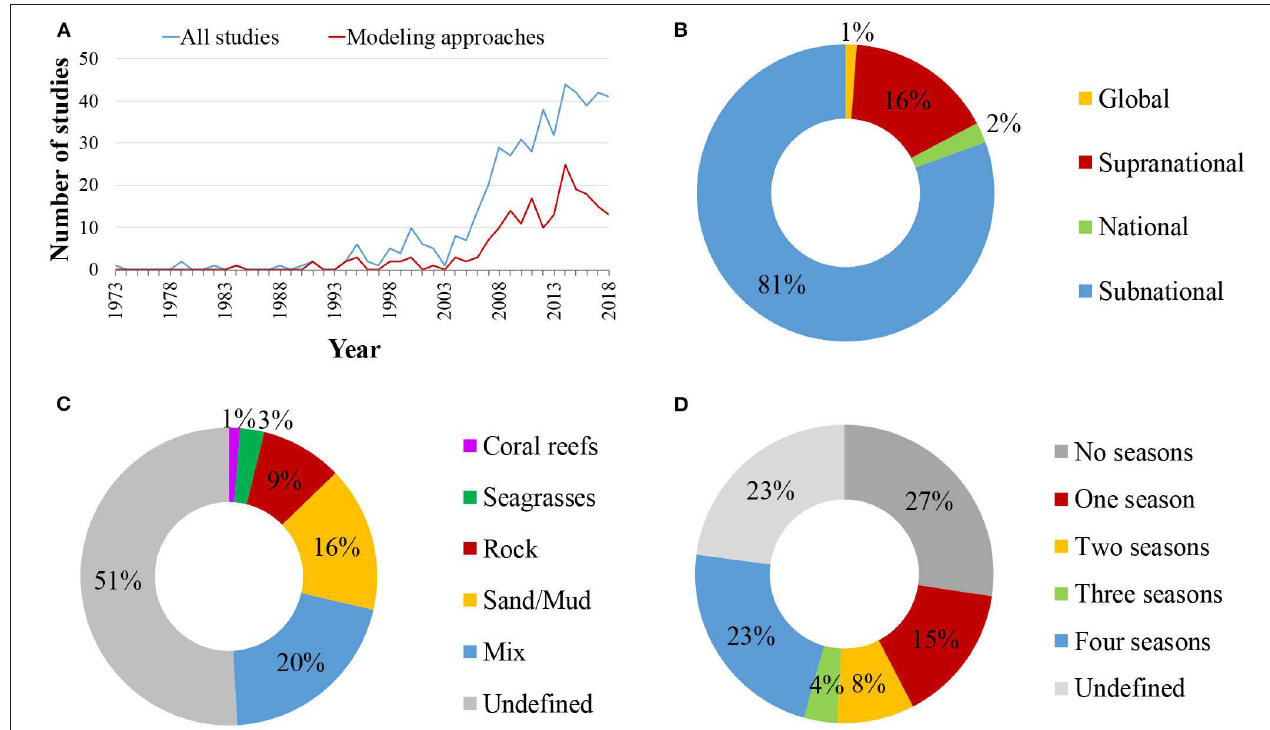
FIGURE 2 | Spatio-temporal identity of the reviewed studies: (A) annual publication rate of coastal shelf food web studies between 1973 and 2018. Blue line: all studies, red line: studies utilizing a modeling approach; (B) spatial scale of the studies; (C) habitat types studied; (D) number of seasons accounted